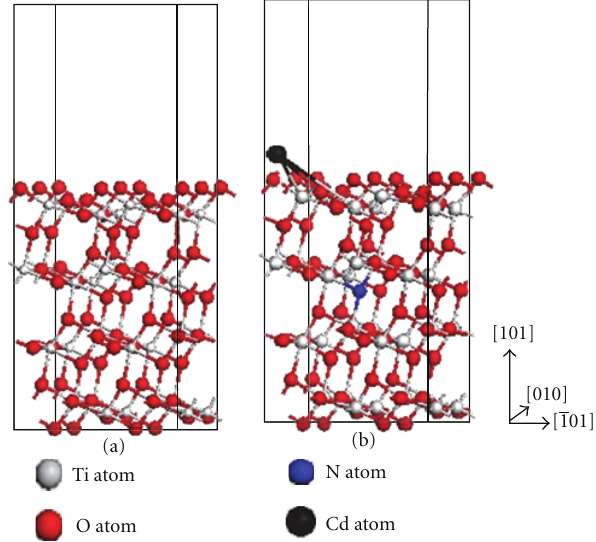
Figure 6: The model of supercells: (a) Ti 32 O 64 , (b) Ti 32 CdO 63 N.